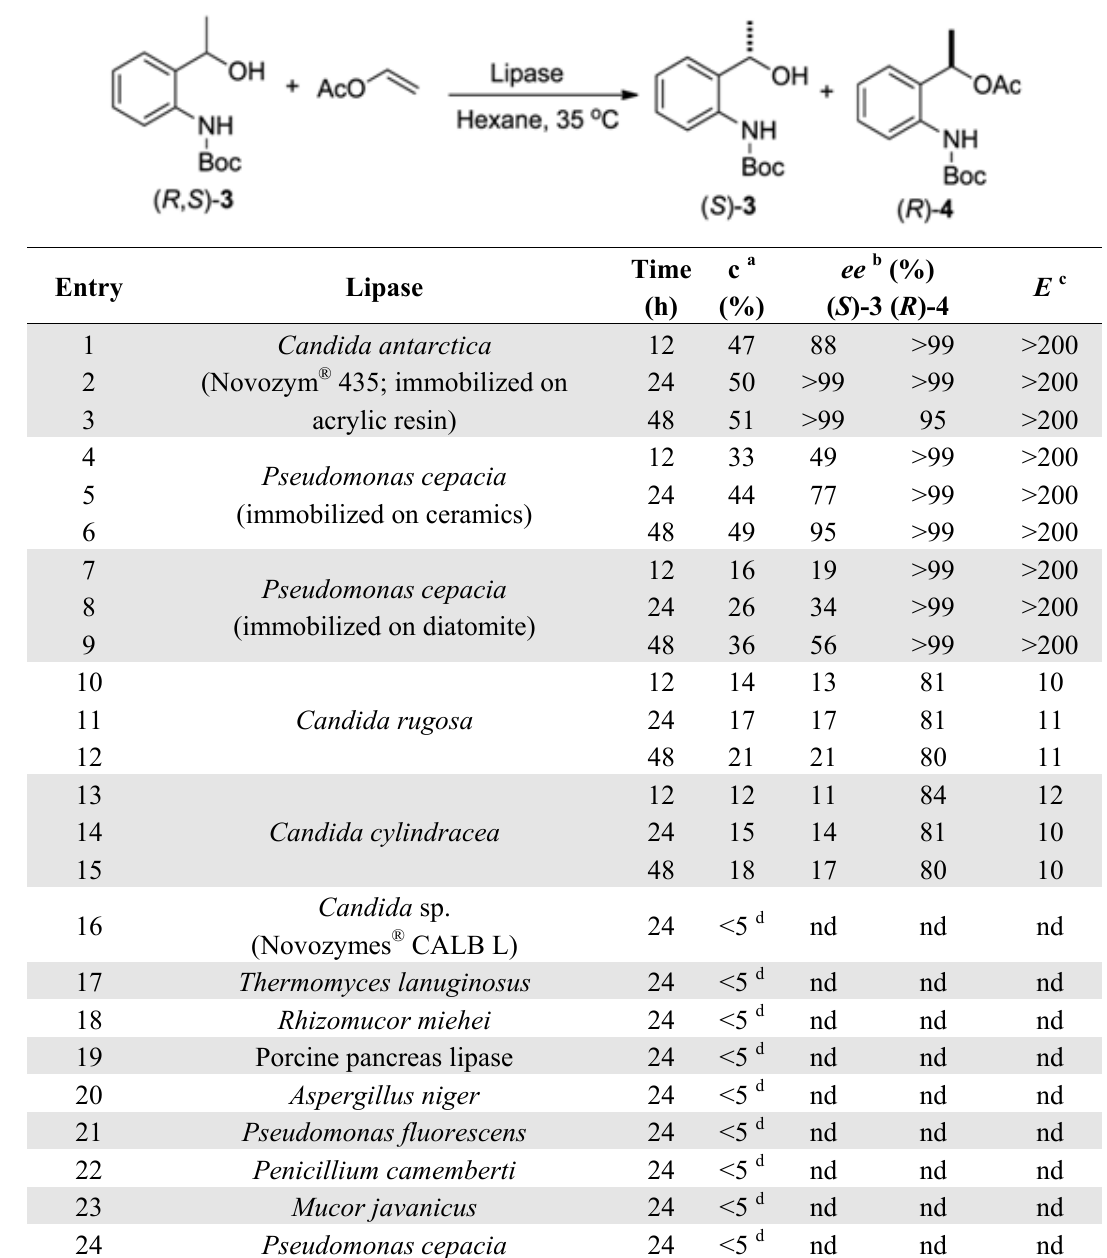
Table 2. Screening of lipases for kinetic resolution of ( R,S )- 3c